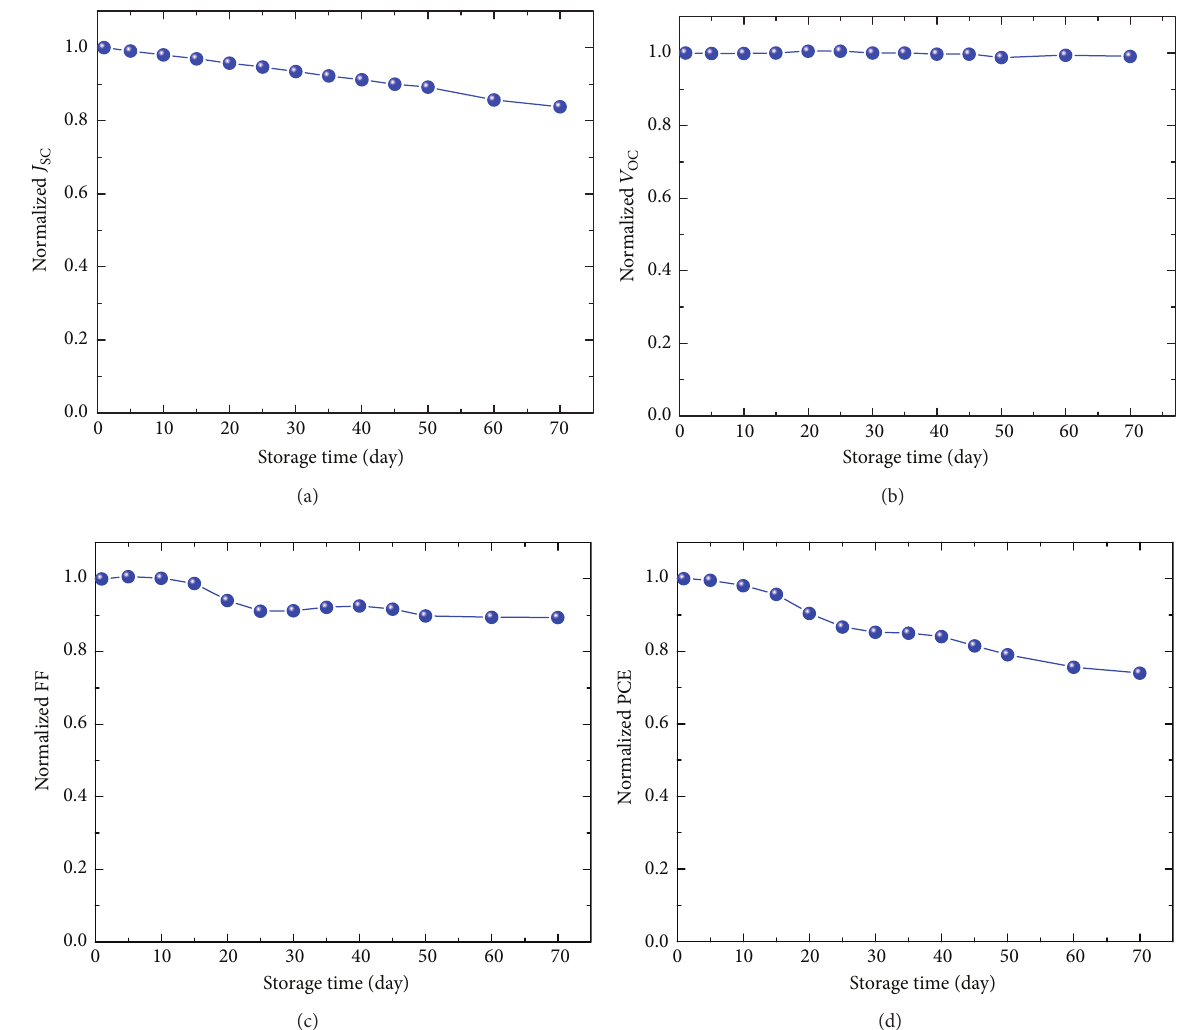
Figure 4: Change of organic photovoltaic parameters, (a) 𝐽 and stored for 70